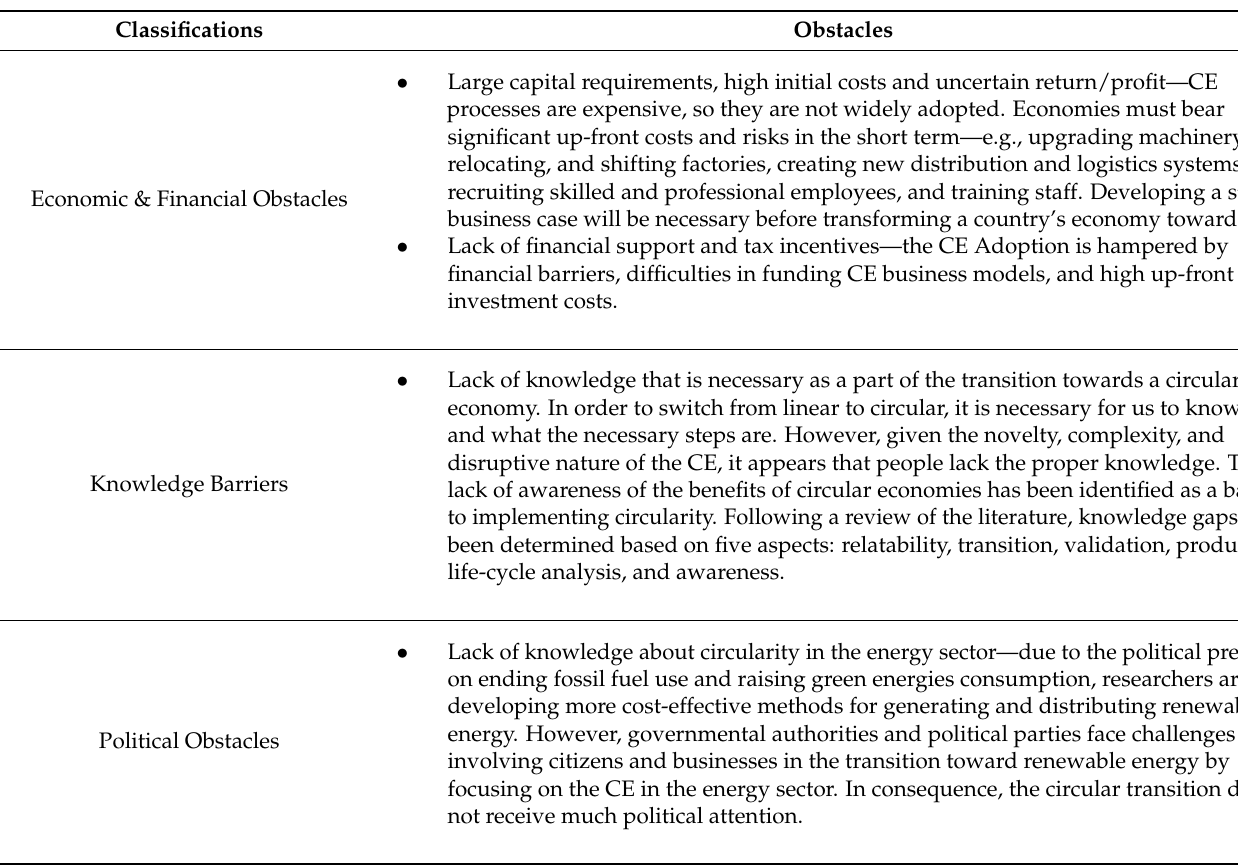
Table 3. Barriers to the CE implementation in global